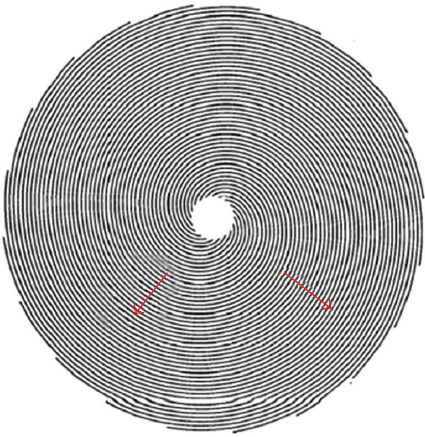
Figure 16: Grating that introduces a constant radial displacement between sheared wavefronts [81].